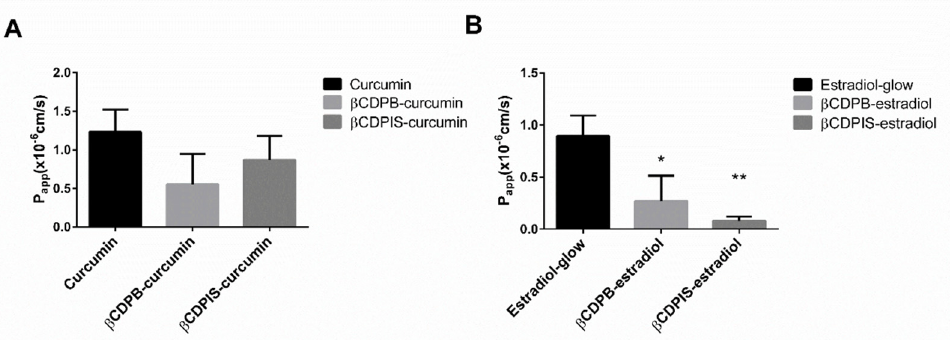
Figure 11. In vitro permeability study of Curcumin ( A ) and Estradiol-glow ( B ) on Caco-2 monolayers (data are presented as means ± SD, n = 3, P app —apparent permeability coefficient, * p <0.05 for β CDPB and ** p <0.01 for β CDPIS compared to control estradiol-glow treatment).